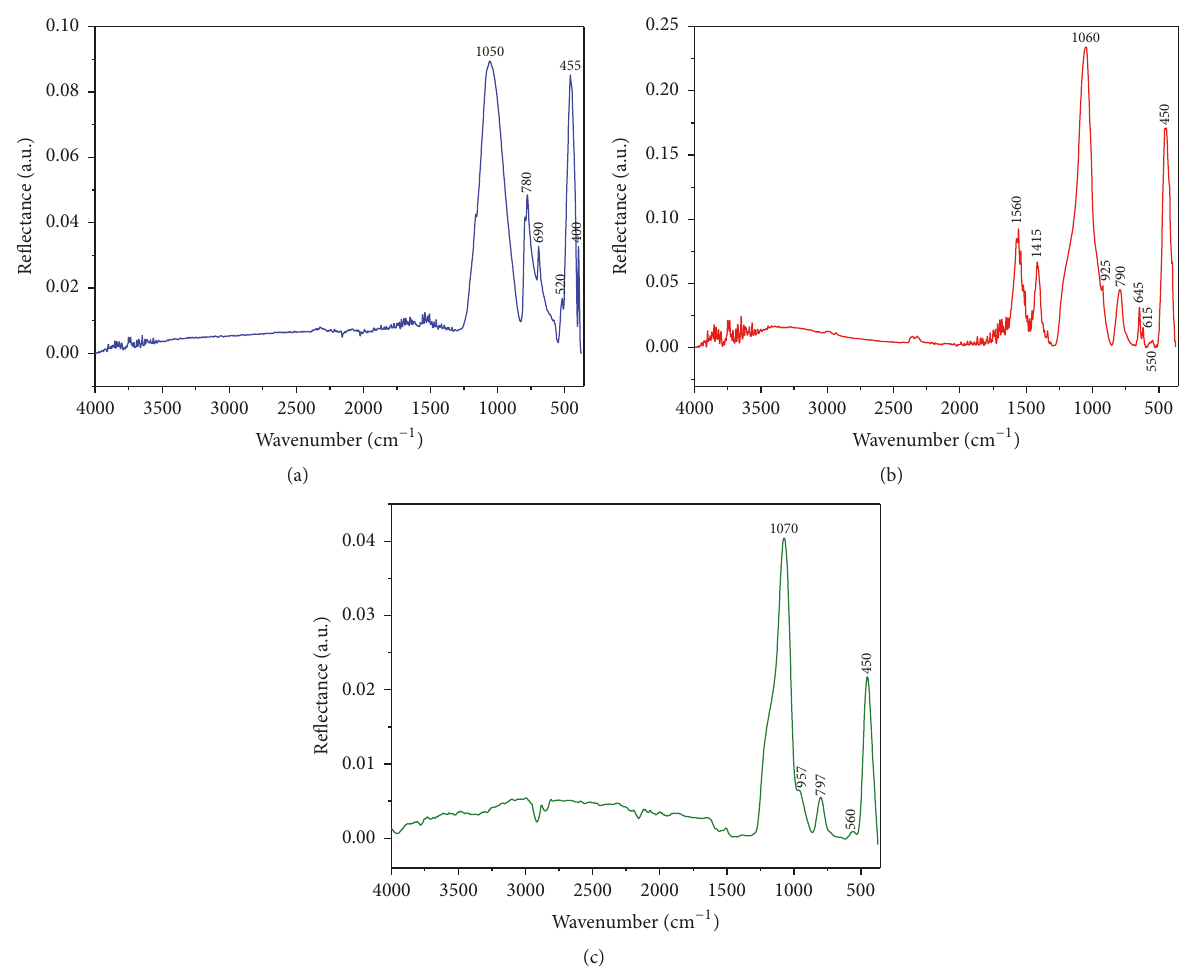
Figure 8: FTIR vibrational spectra for the samples: sugarcane waste ash (a), biosilica (b), and biosilica washed with water (c).